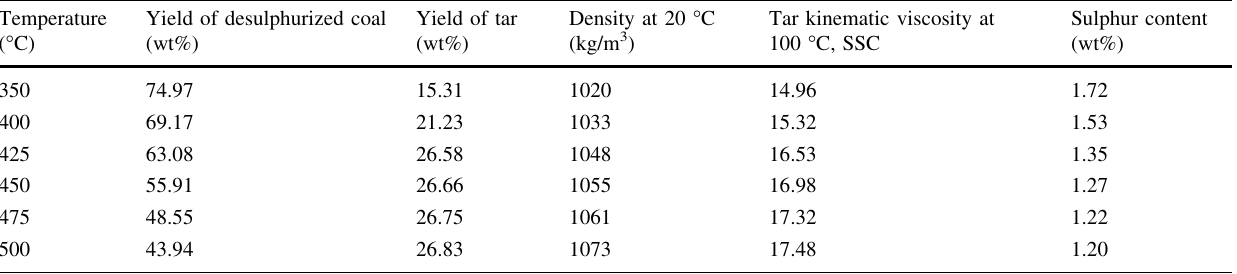
Table 3 Effect of temperature (other fixed conditions: the content of water vapour in the oxidant—70 vol%; OFR—2.4 m 3 /(h kg); the process duration - 15 min) Temperature ( (cid:3)